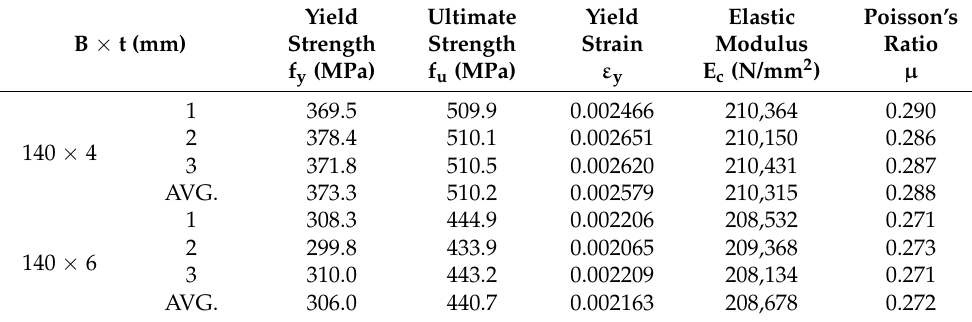
Table 2. Mechanical properties of steel.